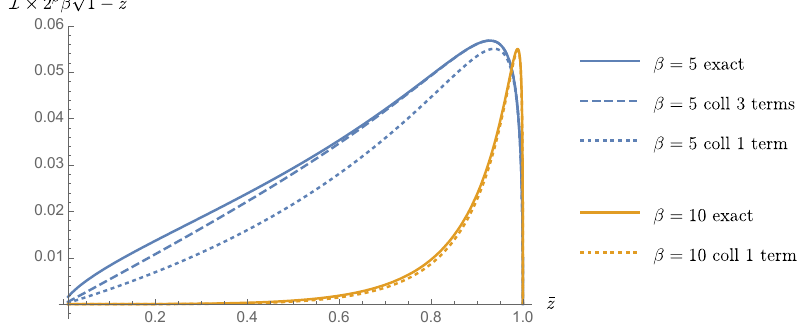
Figure 2 . Integrand of the inversion formula (2.21) with z = 10 − 2 , comparing the exact cross- channel block for (cid:15) -exchange (using the 3d to 2d series) with its collinear series in (1 − ¯ z ) . For β = 5 , the collinear limit in eq. (2.30) approximates the dominant region well but underestimates the integrand at small ¯ z . At larger values of β this region becomes negligible. Note that we rescaled √ the integrand by 2 β β 1 − ¯ z to make features more